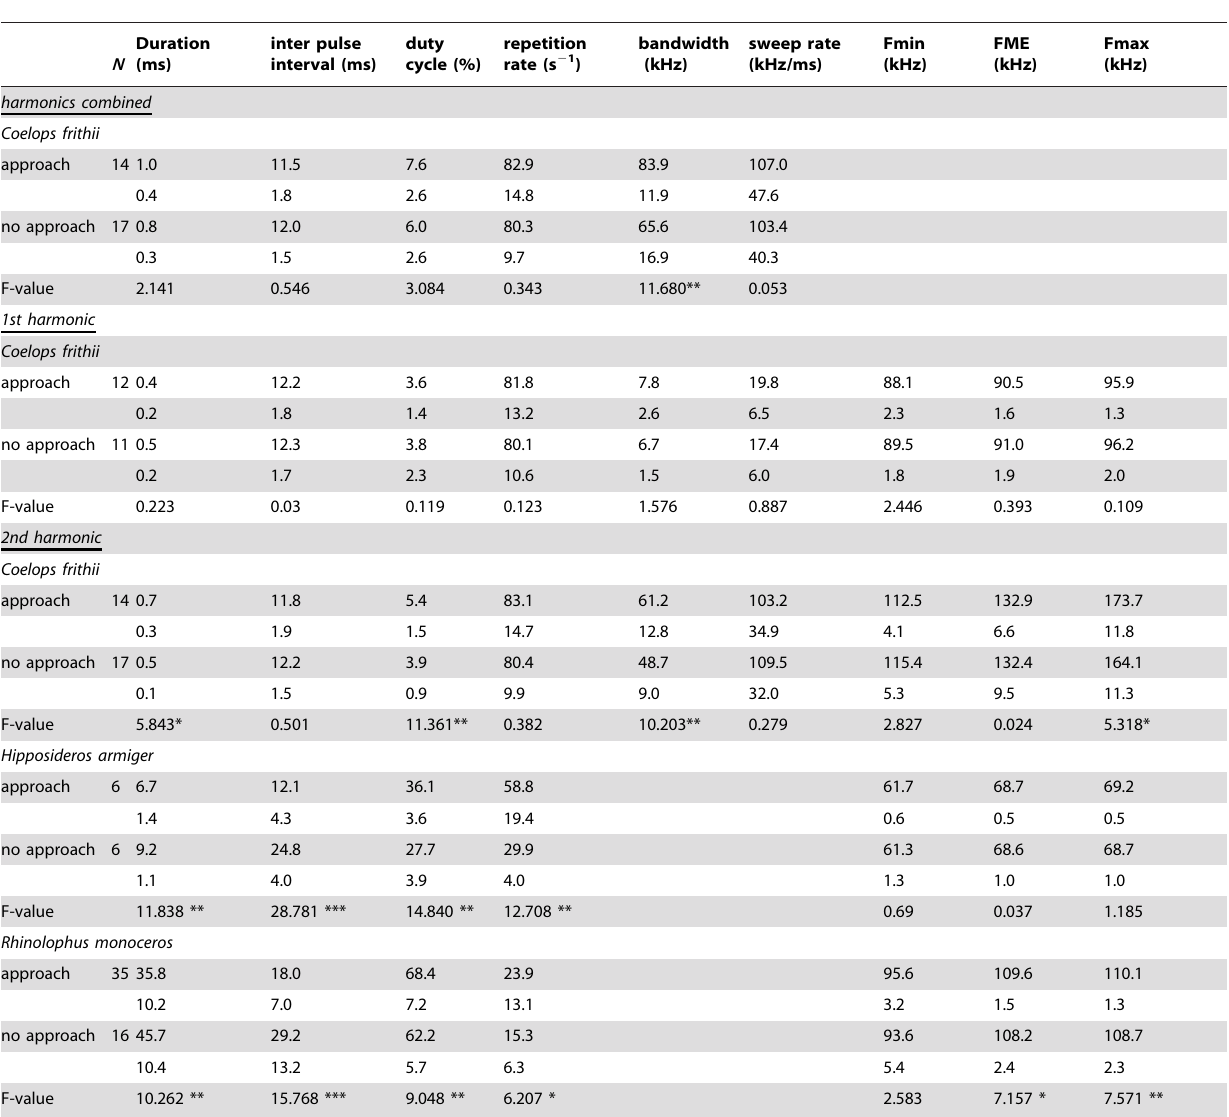
Table 2. Comparisons of echolocation call parameters between bats that approached and did not approach to the fluttering